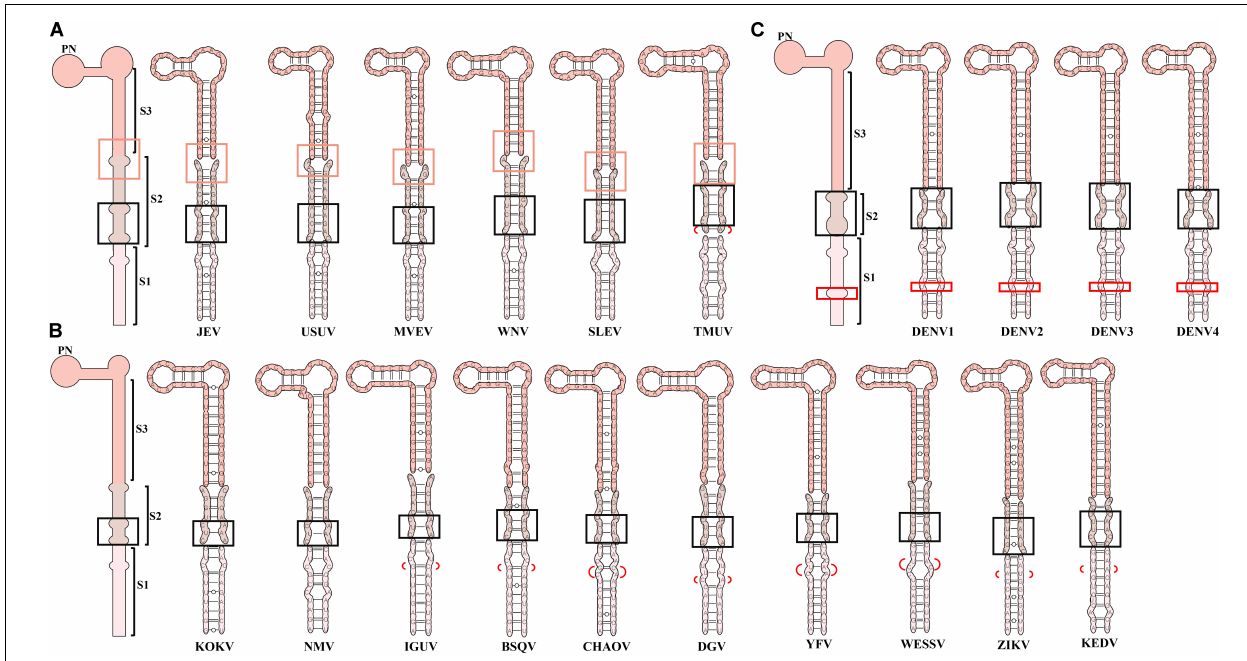
FIGURE 8 | A comprehensive analysis on the 3 (cid:48) SL conformations of MBFVs. Homologous stems and elements are defined in the 3 (cid:48) SL according to the loci of corresponding bulges in (A) JEVG, NTAVG. (B) KOKVG, AROVG, LAMVG, YFVG, SPOVG, and (C) DENVG. A general common structural architecture of 3 (cid:48) SL in the close group is depicted for (A) JEVG, NTAVG. (B) KOKVG, AROVG, LAMVG, YFVG, SPOVG, and (C) DENVG. Three homologous stems (S1, S2, S3) were defined in corresponding colors. The highly conserved homologous bulge and adjacent structure are indicated by the orange box in JEVG and NTAVG. The homologous bulge in the S2 region is indicated by a black box in each group. The extra base-pair insertion in the S1 region is shown in the red bracket or box. Special TMUV/CQW1 insertion marked by the red bracket is in S2 region.